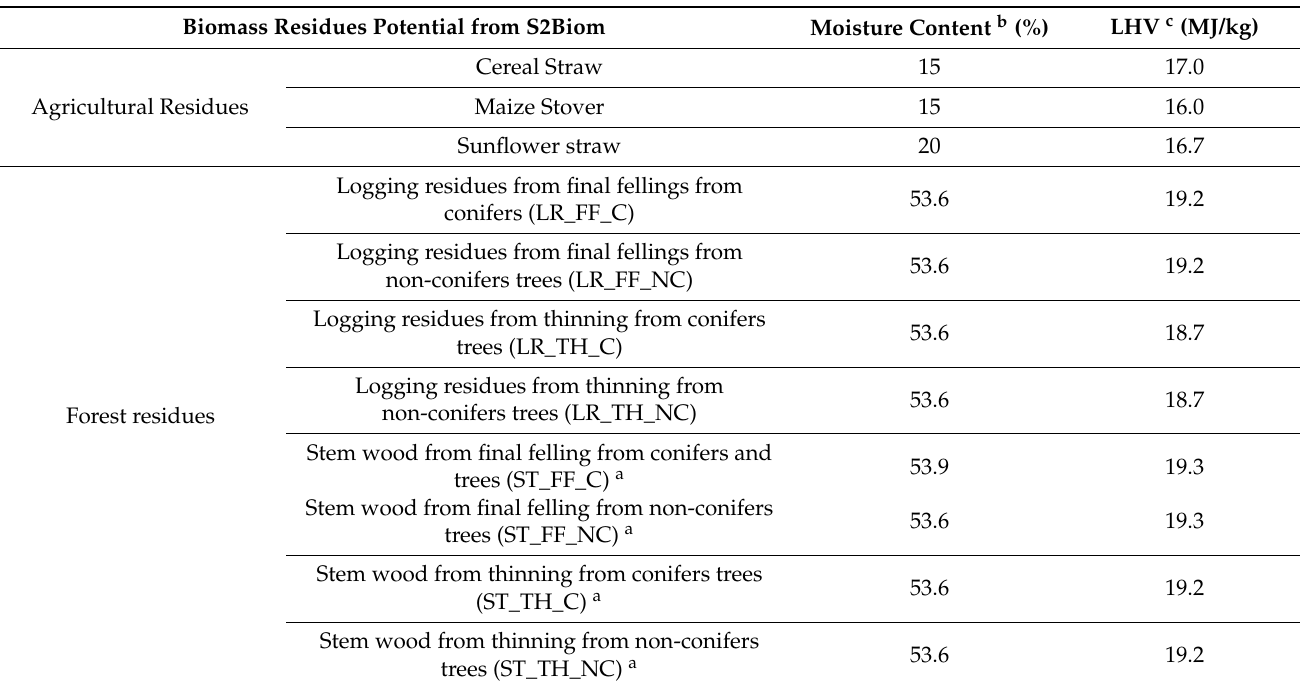
Table 2. Parameters considered for agricultural and forest residues potential estimates in Europe. Notes: a : Final fellings and thinnings from coniferous/non-coniferous plantations and semi-natural forests are the small trees from management operations or left over after a final harvest for which there may be no demand (or no suitability) for use as pulp wood. For this reason, stemwood was considered in this study for Europe; b : As received [41]; c : Dry basis